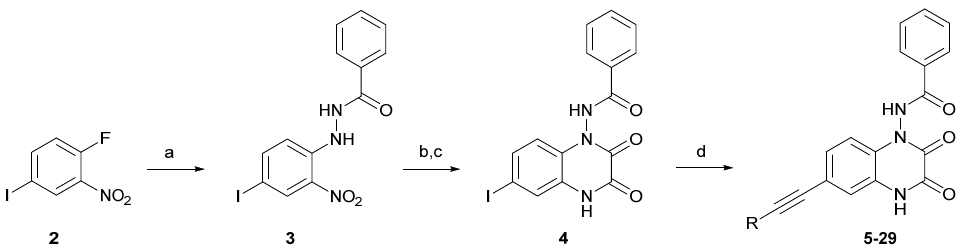
Figure 1. Structures of selected AMPA/kainate receptor antagonists based on the quinoxaline-2,3- dione